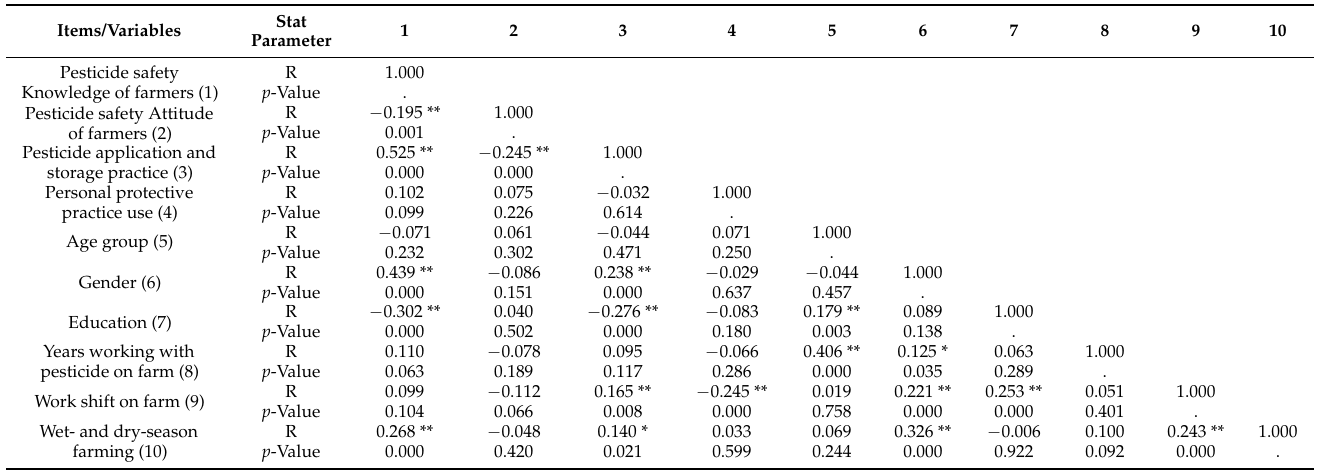
Table 6. Spearman’s rho correlations between sets of variables